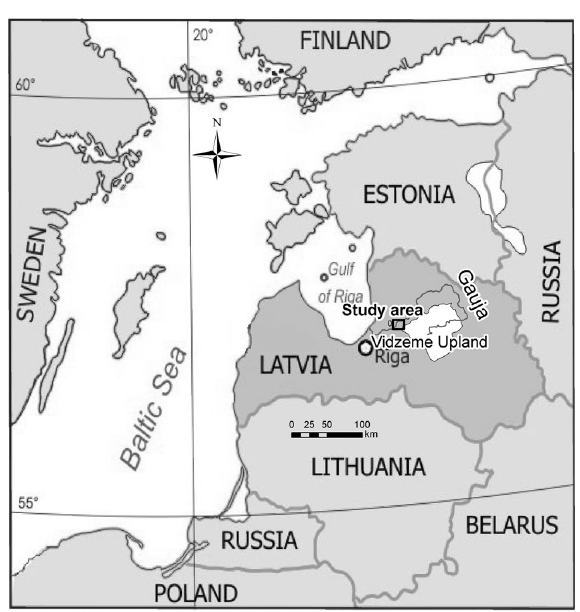
Fig. 1. Location of the study area.